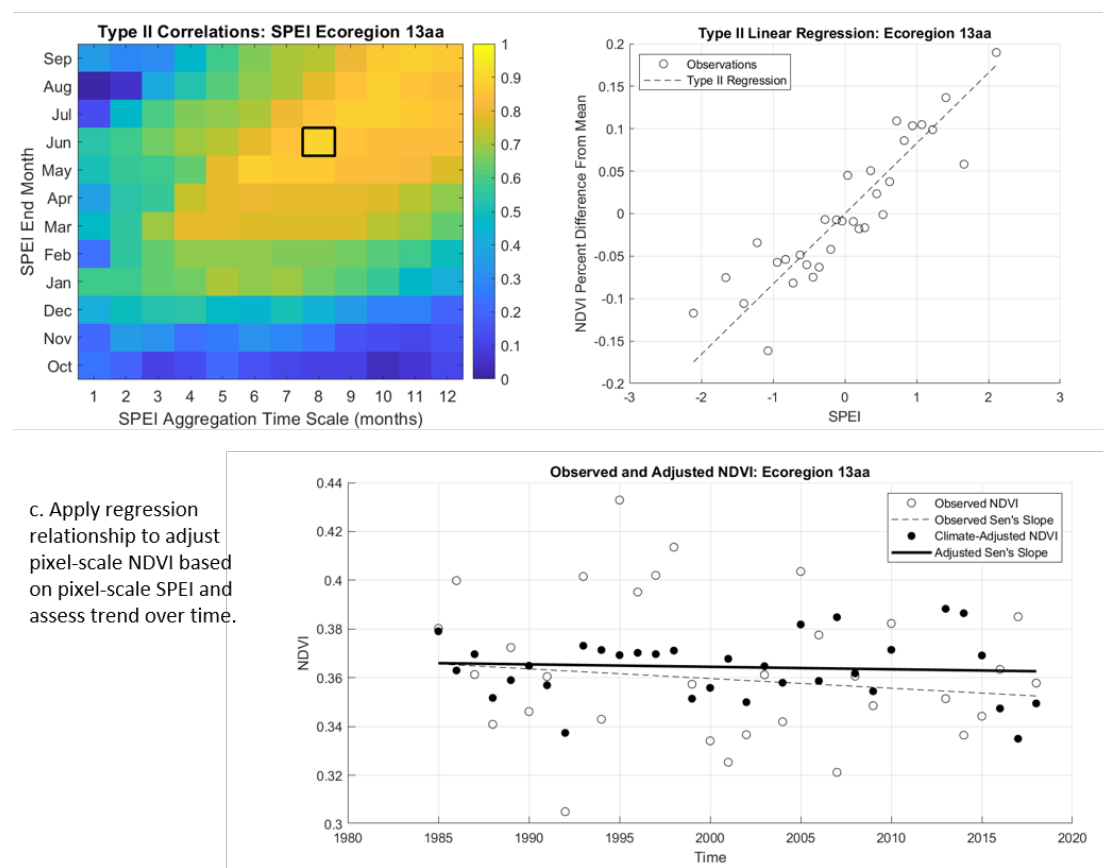
Figure 2. Methodological steps for ( a ) identifying the timescale of the strongest relationship between Standardized Precipitation–Evapotranspiration Index (SPEI) and percentage change in Normalized Di ff erence Vegetation Index (NDVI) for each ecoregion in the study area, ( b ) quantifying the regression slope of that strongest relationship, and ( c ) applying the ecoregional relationship to the pixel scale to adjust for drought and analyze resultant trends over